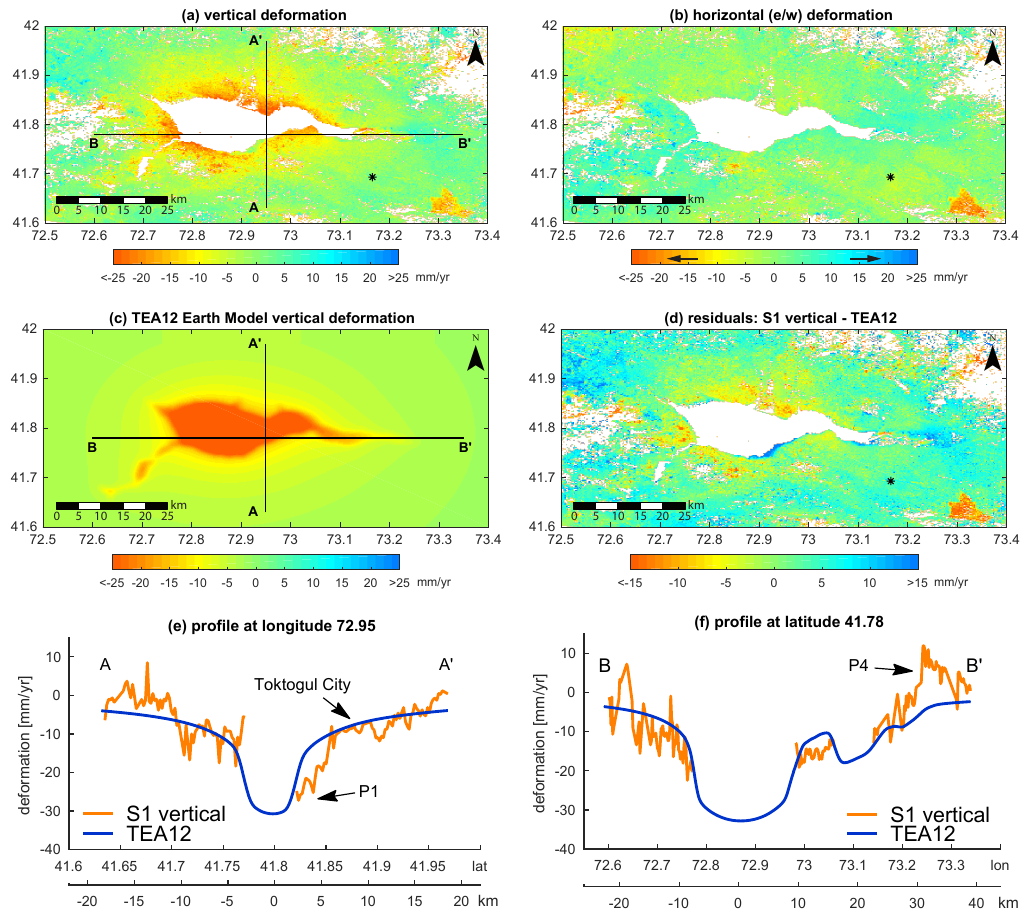
Figure 8. ( a ) vertical and ( b ) horizontal (east/west) components of the decomposed Sentinel-1 ascending and descending LOS deformations for the time period March 2015–November 2016. Input data for the decomposition are the power-law-corrected mean LOS deformation maps; ( c ) vertical deformation from elastic modelling with the TEA12 Earth model; and ( d ) residuals from Sentinel-1 minus modelled vertical deformation. Negative values in the vertical case refer to subsidence, and blue values refer to uplift. In the horizontal case, positive values denote a motion towards the east, and negative values denote a motion towards the west. The black asterisk shows the location of the reference point. Measured and modelled vertical deformation rates for profiles AA (cid:48) and BB (cid:48) are given in ( e , f ),